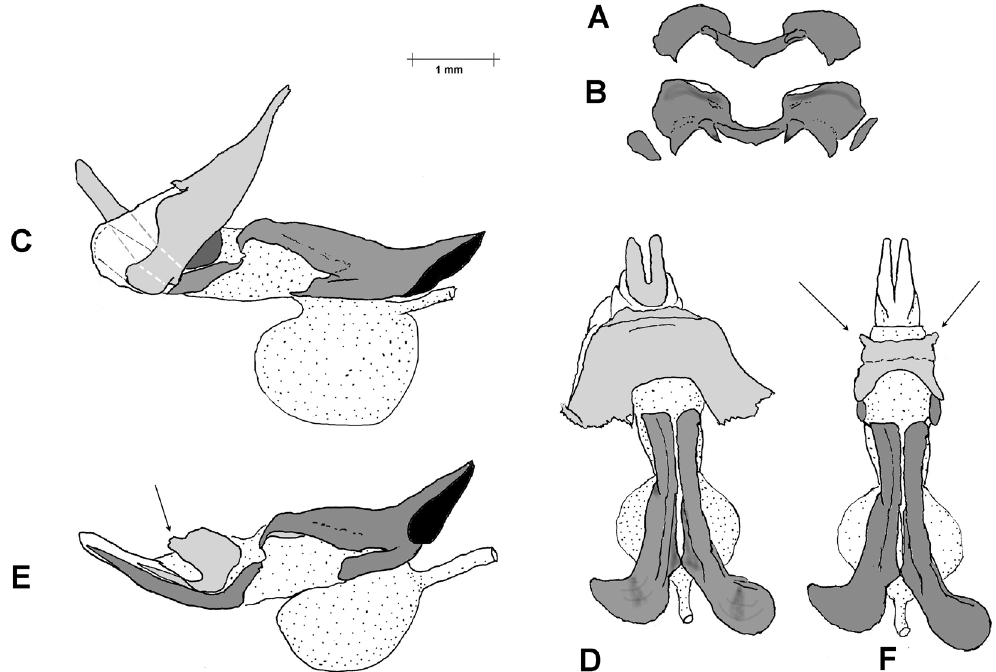
Fig. 7. Serpusia opacula , phallus. A. Epiphallus, axial view; B. Epiphallus, dorsal view; C. Phallic complex after removal of epiphallus and epiphallic membrane, lateral view; D. As in C, but dorsal view. In this preparation the cingular apodemes are broken off; intact, they resemble those of S. succursor (Fig. 8), being long and straight and almost parallel; E. Endophallus and arch, lateral view; F. As in E, but dorsal view. In E and F, the arrows indicate cut margins of the arch where it has been freed from the inner surface of the